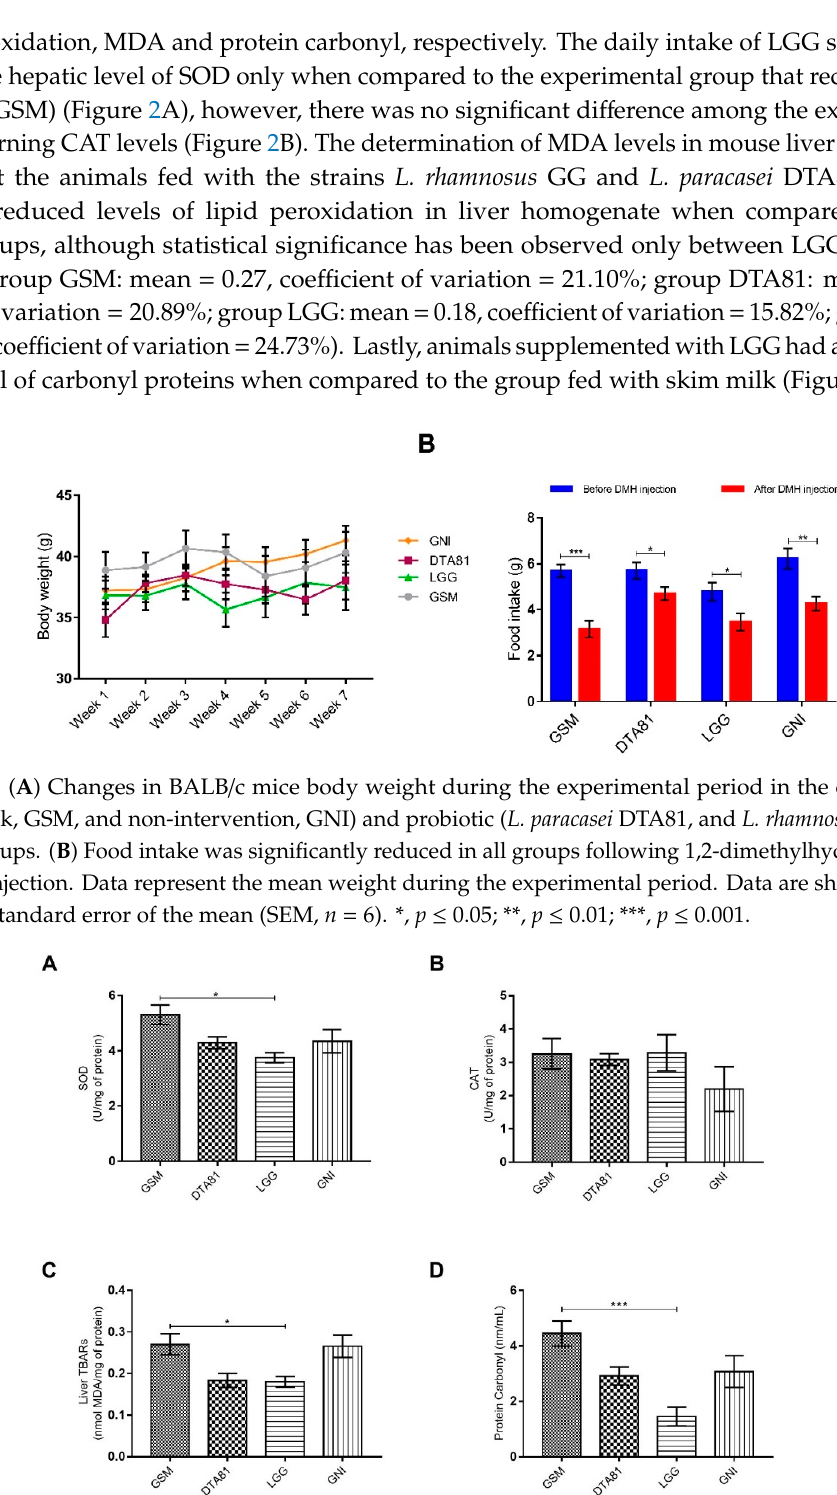
Figure2. Oxidantstatusmarkersintheliver. Effectof L.paracasei DTA81(DTA81)or L.rhamnosus GG(LGG) in liver tissue of male BALB / c animals subjected to 1,2-dimethylhydrazine. ( A ) superoxide dismutase (SOD) activity; ( B ) catalase (CAT) activity; ( C ) malondialdehyde (MDA); ( D ) protein carbonyls. The data are expressed as means ± SEM ( n = 6). *, p ≤ 0.05; ***, p ≤